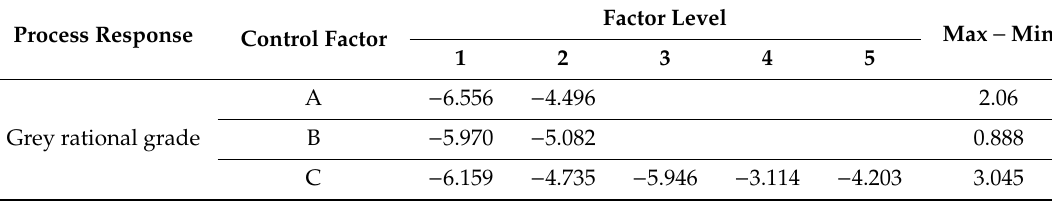
Table 6. Average of the S / N ratios of each level of the control factors for the grey rational